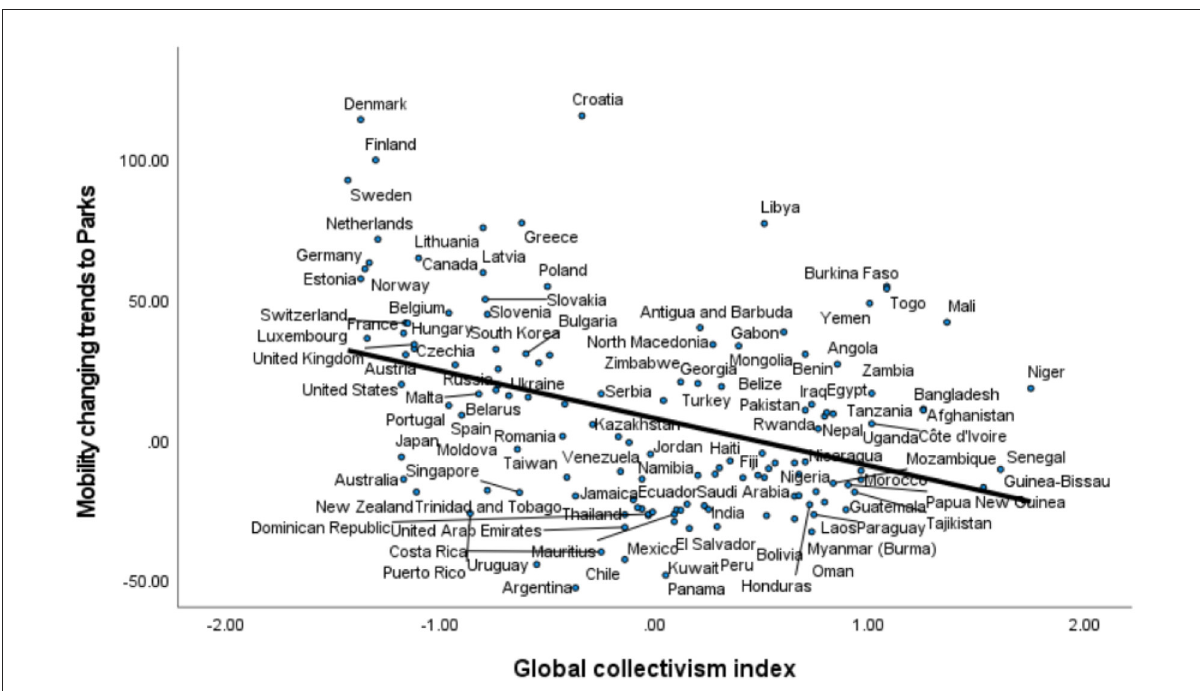
FIGURE2 Mobility trends to Parks reduced more in more collectivist